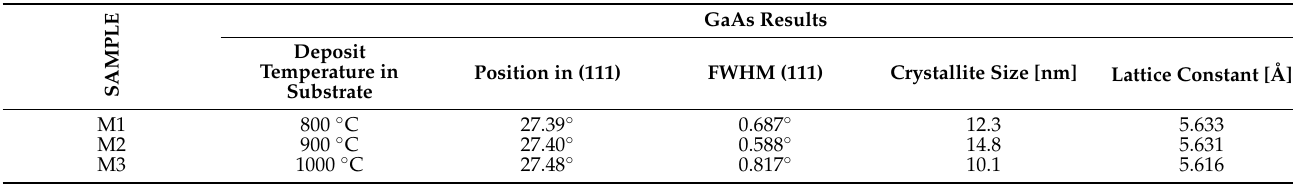
Table 2. Lattice Parameter and crystallite size of GaAs films grown by